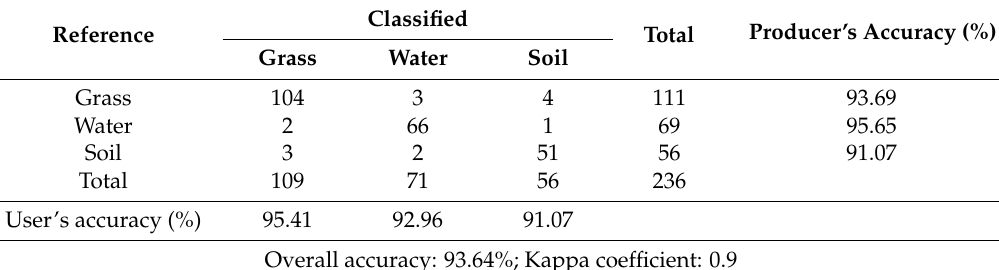
Table 2. Confusion matrix and accuracy estimates for the classified